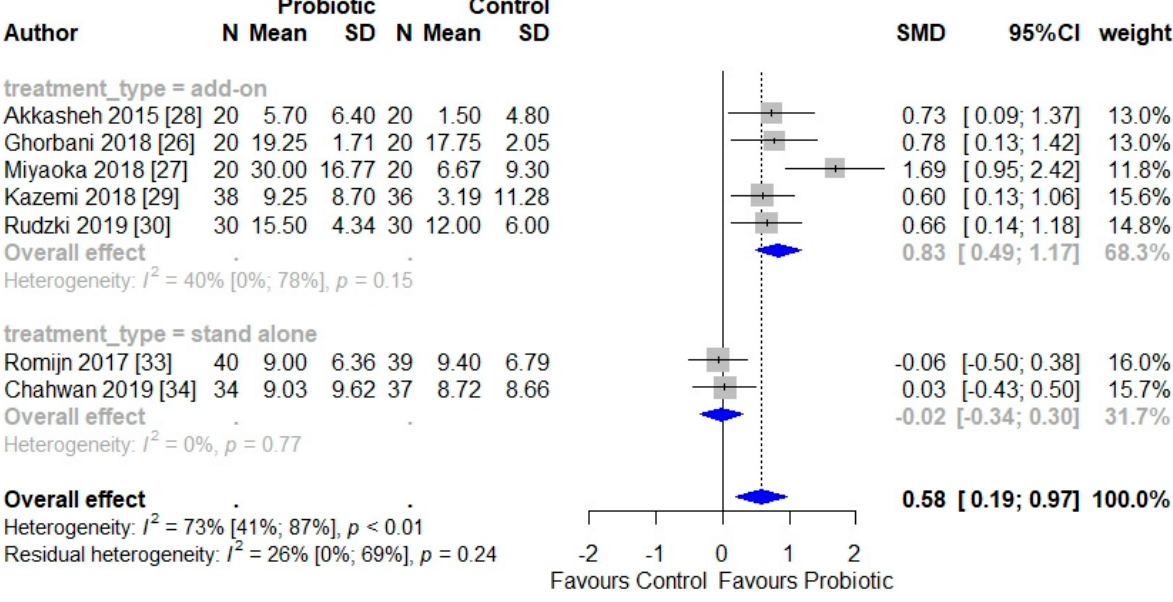
Figure 2. Forest plot of reduction in depressive symptoms post ‐ treatment, grouped by treatment type (adjunctive vs. stand ‐ alone).